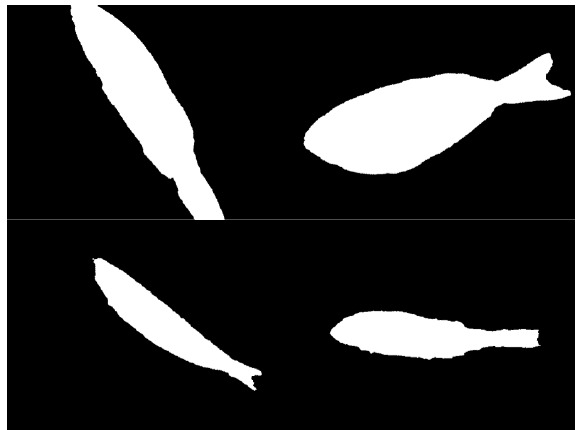
Figure 16. The segmentation results of our model.